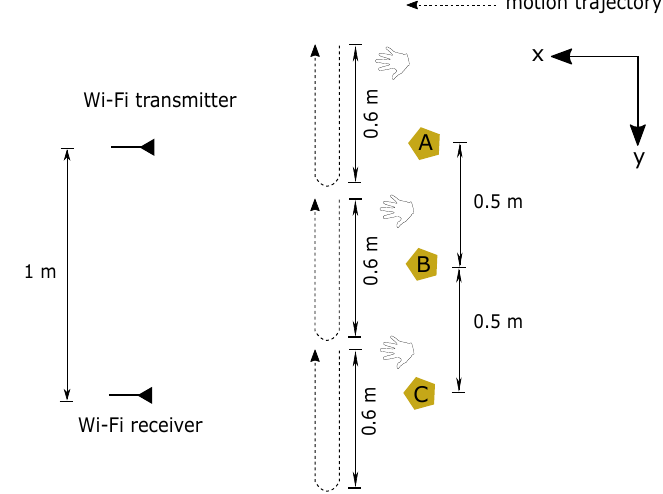
Figure 11. Experiment scenarios of hand motion detection at point A, B, and